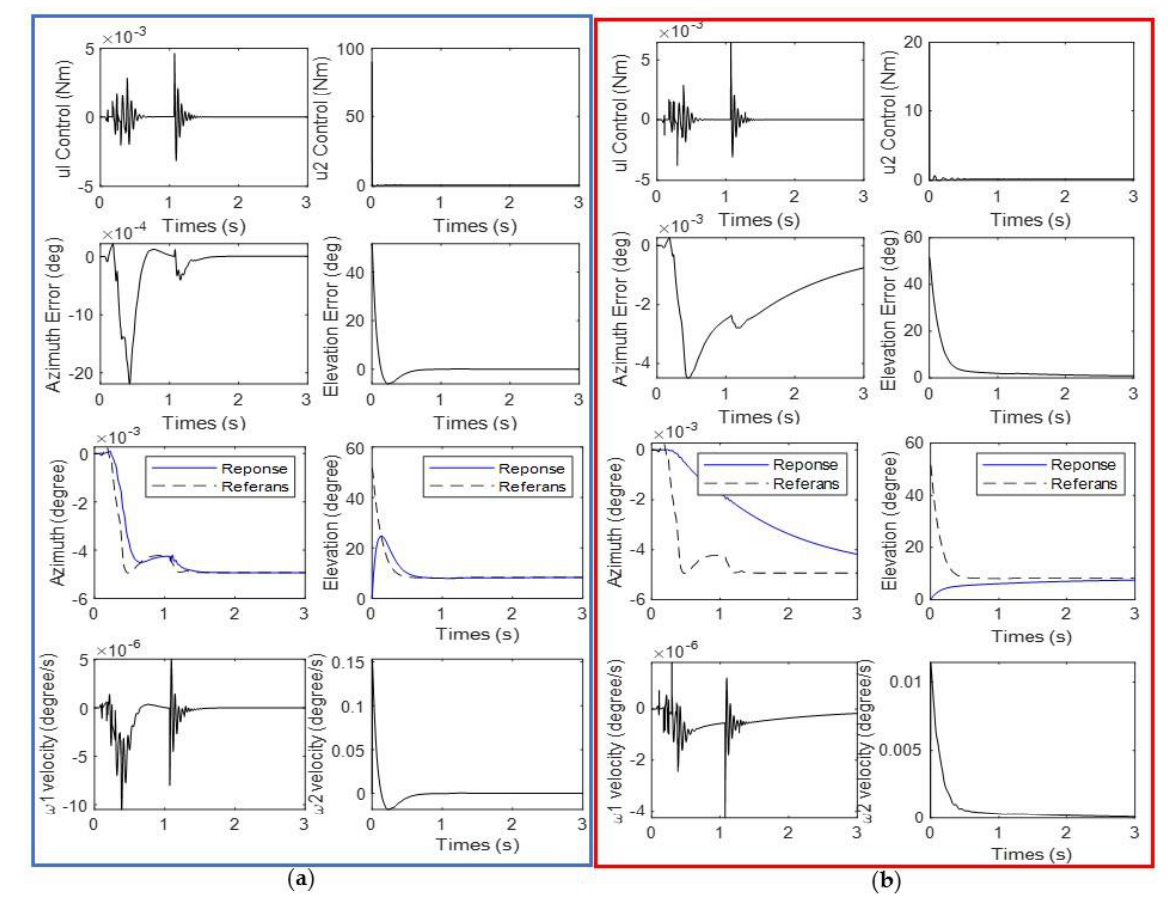
Figure 14. Control signals, error values, trajectory and velocity of Turret System elevation and azimuth motor with ( a ) SMC ( b ) PID controllers for Scenario 1.